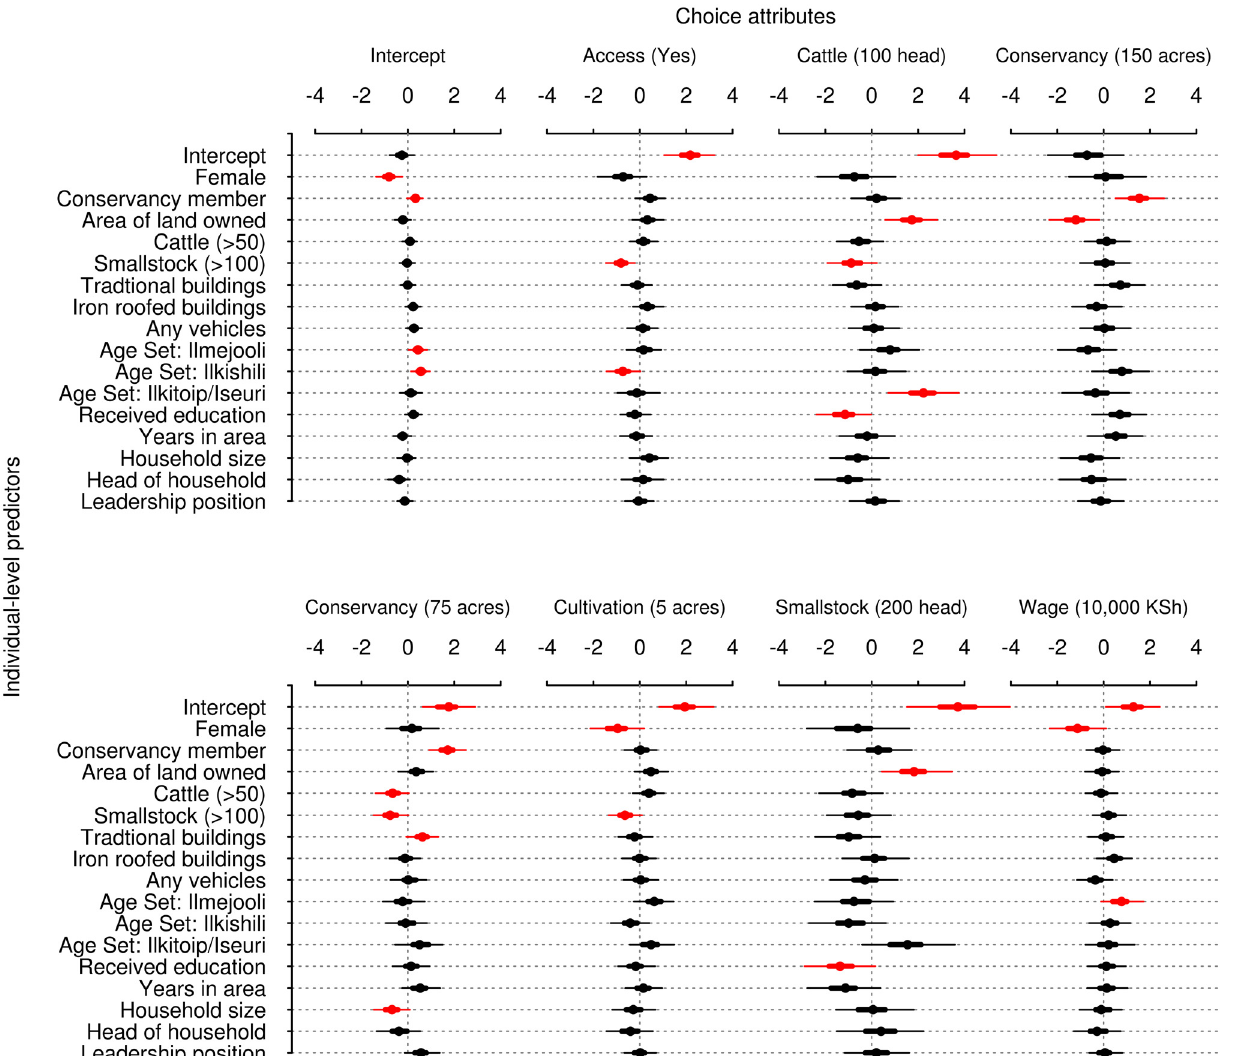
Fig 2. Parameter estimates from Model 3, the fitted model including the full suite of interactions between socio-economic characteristics and choice attributes. Points indicate posterior means, thin lines indicate 95% highest posterior density interval and heavy lines indicate 50% highest posterior density intervals. As a visual aid to interpretation, parameters whose 90% highest posterior density intervals do not include zero are highlighted in